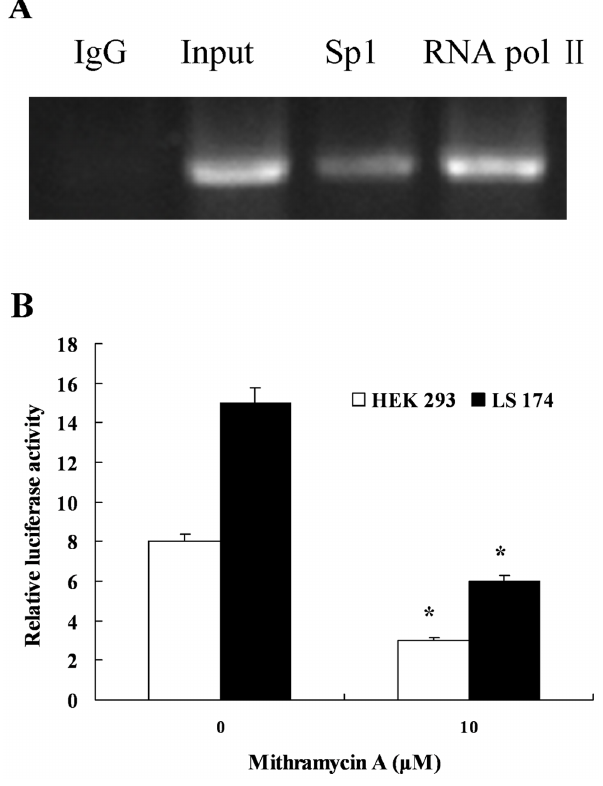
Figure 4. Verification of Sp1 binding at the hTFF3 promoter. A. ChIP assay: LS174T cells were fixed with formalin, and then the chromatin was cleaved by sonication. The cleaved chromatin was then incubated with an anti-Sp1 antibody, a positive control RNA polII antibody, and a negative control IgG antibody. Finally, Sp1 binding at the hTFF3 promoter was assessed by PCR amplification. B. HEK293 or LS174T cells were co-transfected with pGL3-300 and pRL-TK, and then treated with different concentrations of mithramycin A (a Sp1 inhibitor) for 24 h. Relative luciferase activity was measured and calculated. Data are presented as the mean 6 SD (*P , 0.05 vs . 0 m M mithramycin A).